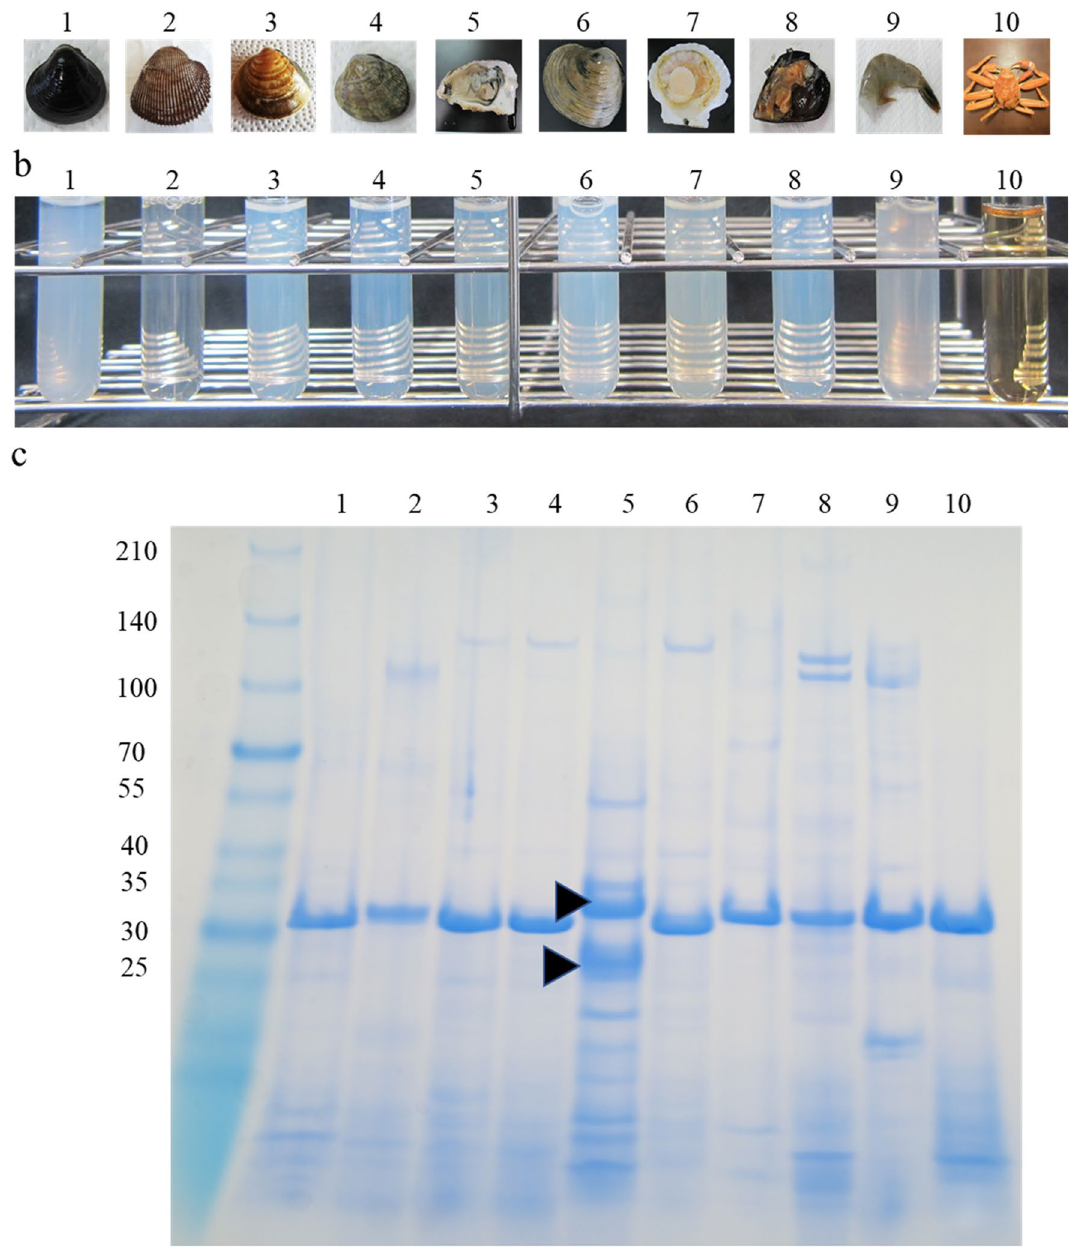
( Corbicula japonica ). (2) Bloody clam ( Anadara broughtonii ). (3) Asiatic hard clam ( Meretrix lusoria ). (4) Japanese littleneck ( Venerupis philippinarum ). (5) Pacific oyster ( Crassostrea gigas ). (6) Hard clam ( Mercenaria mercenaria ). (7) Japanese scallop ( Patinopecten yessoensis ). (8) Mediterranean mussel ( Mytilus galloprovincialis ). (9) White leg shrimp ( Litopenaeus vannamei ). (10) Snow crab ( Chionoecetes opilio ). The arrows indicate the bands used in MALDI-TOFMS/MS analysis, namely the upper and lower